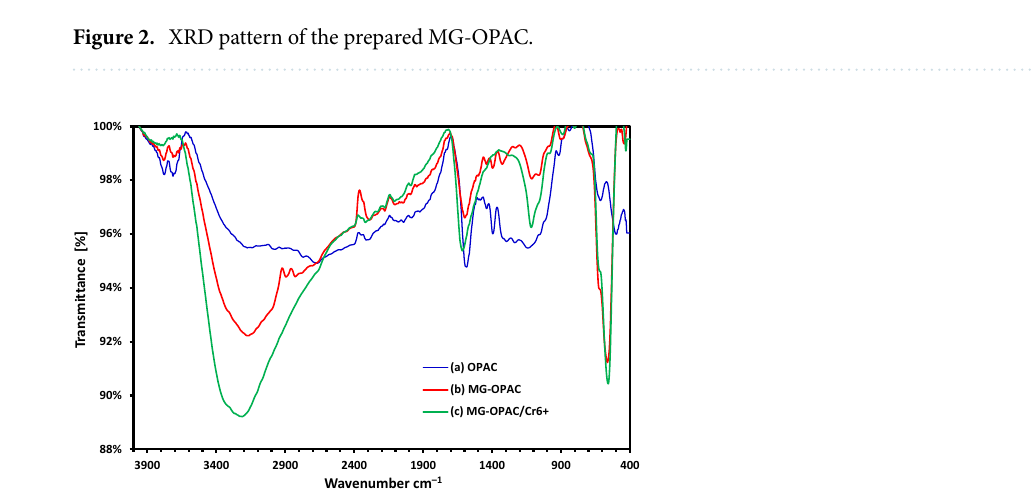
Figure 3. FTIR investigation of ( a ) OPAC, ( b ) MG-OPAC, ( c ) Cr 6+ ions absorbed on MG-OPAC.